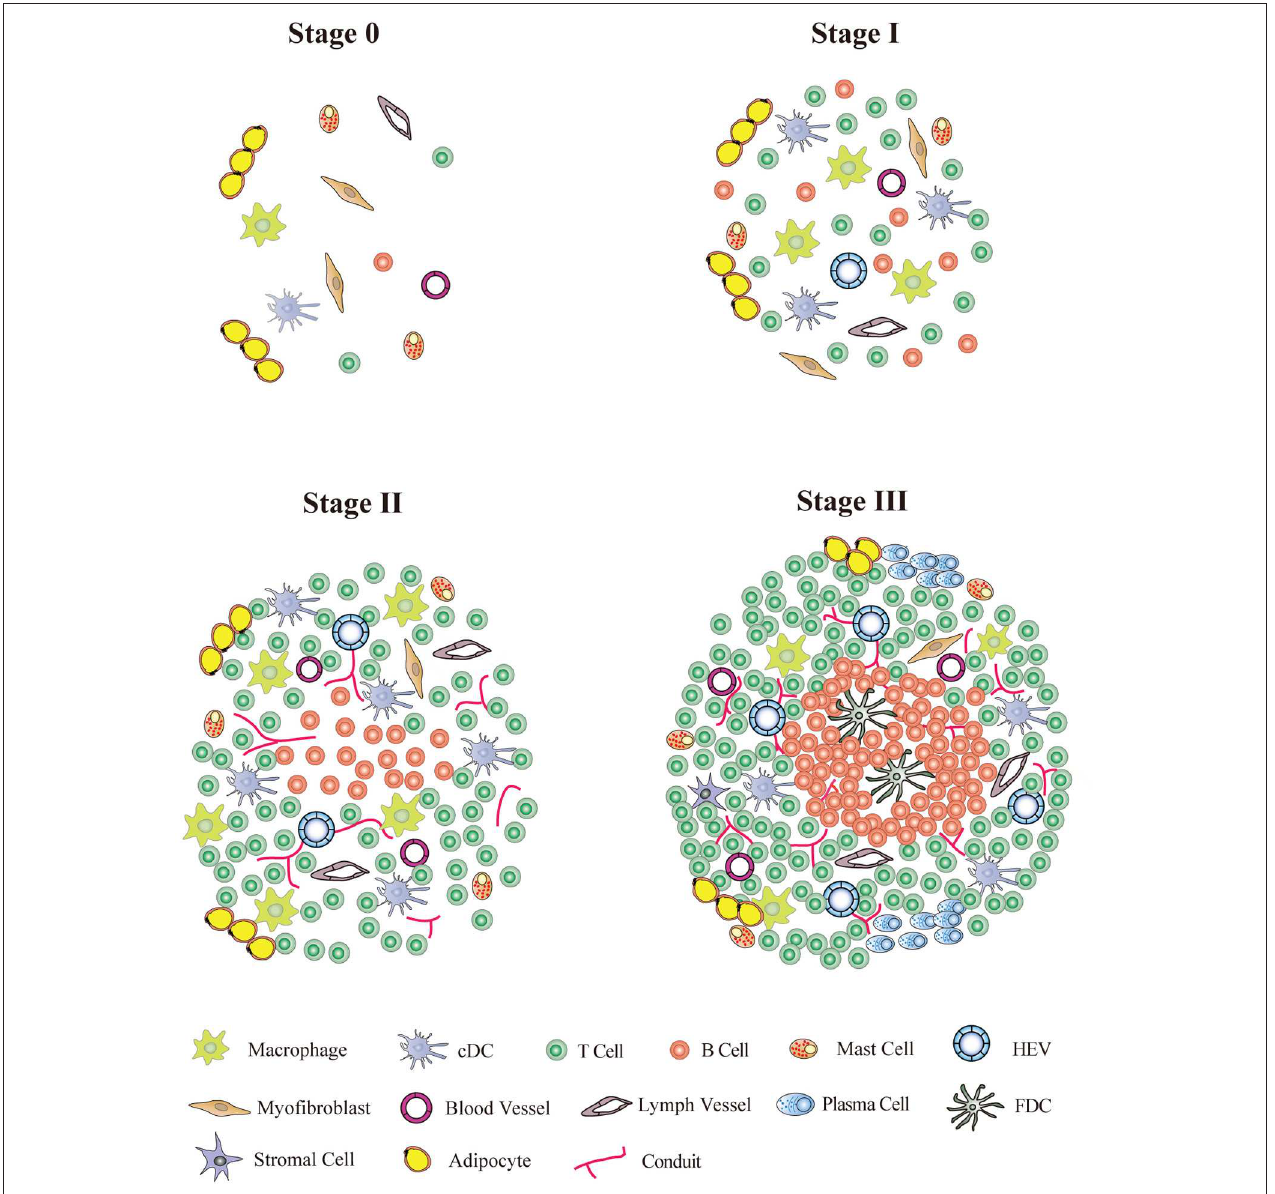
FIGURE 1 | TLO stage classification. Stage 0, normal tissue without TLO formation; Stage I, early TLOs with mixed T/B-cell aggregates; Stage II, pre-TLOs with segregated T/B-cell area with lymph vessels and conduits; Stage III, well organized TLOs containing segregated T-cell area and B-cell follicles with germinal centers and follicle DC